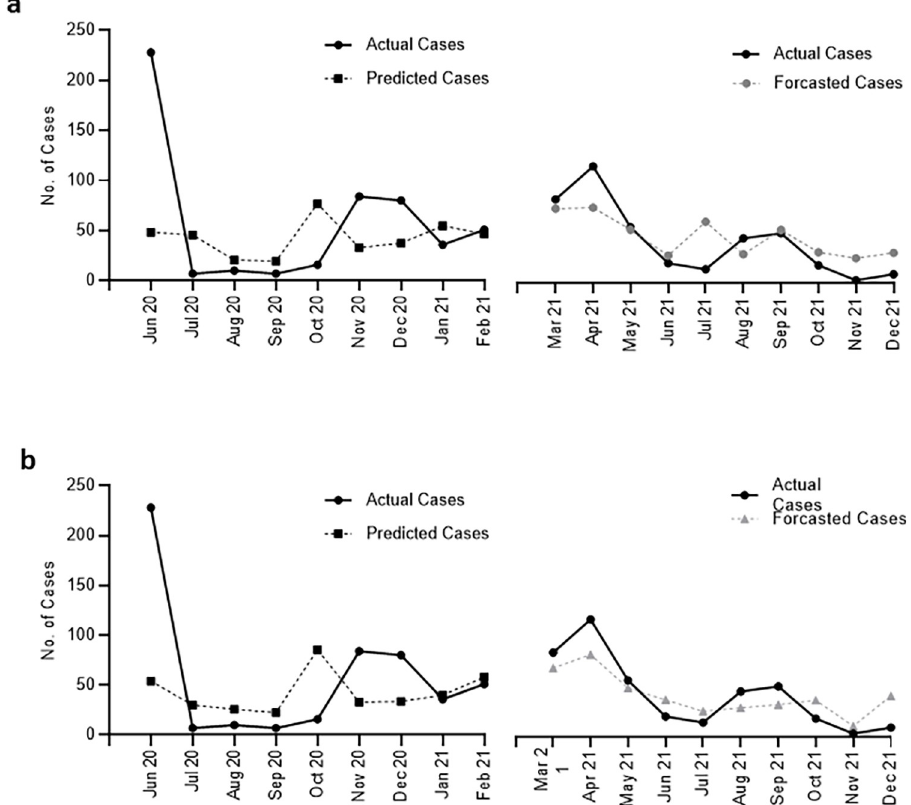
Fig 4. Actual and predicted cases using a linear regression model generated from monthly median Ct values. (a) The model was generated using Ct values for all COVID-19 cases. (b) The model was generated using Ct values of asymptomatic COVID-19 cases. The models were generated with Ct values of COVID-19 cases between Jun 2020 and Feb 2021. Data collected from Mar 2021 until Dec 2021 were used to validate the forecasting estimates.